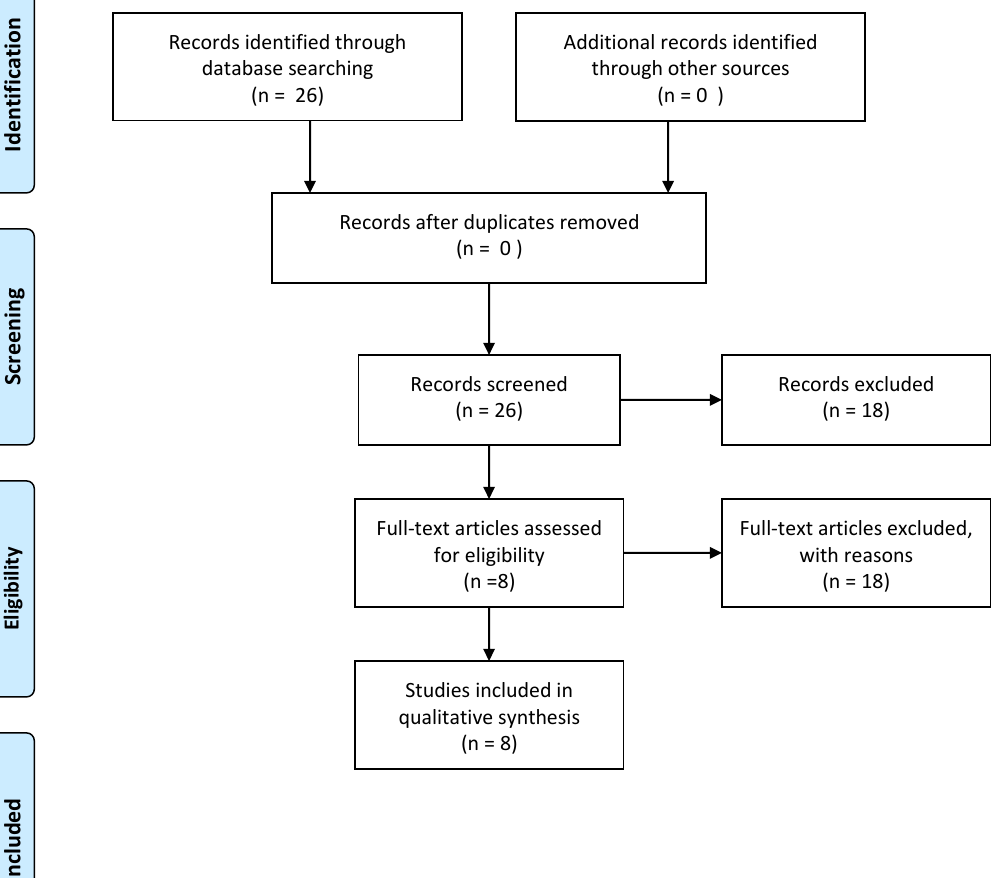
Figure 1. Flow diagram of information through the different phases of a systematic review.